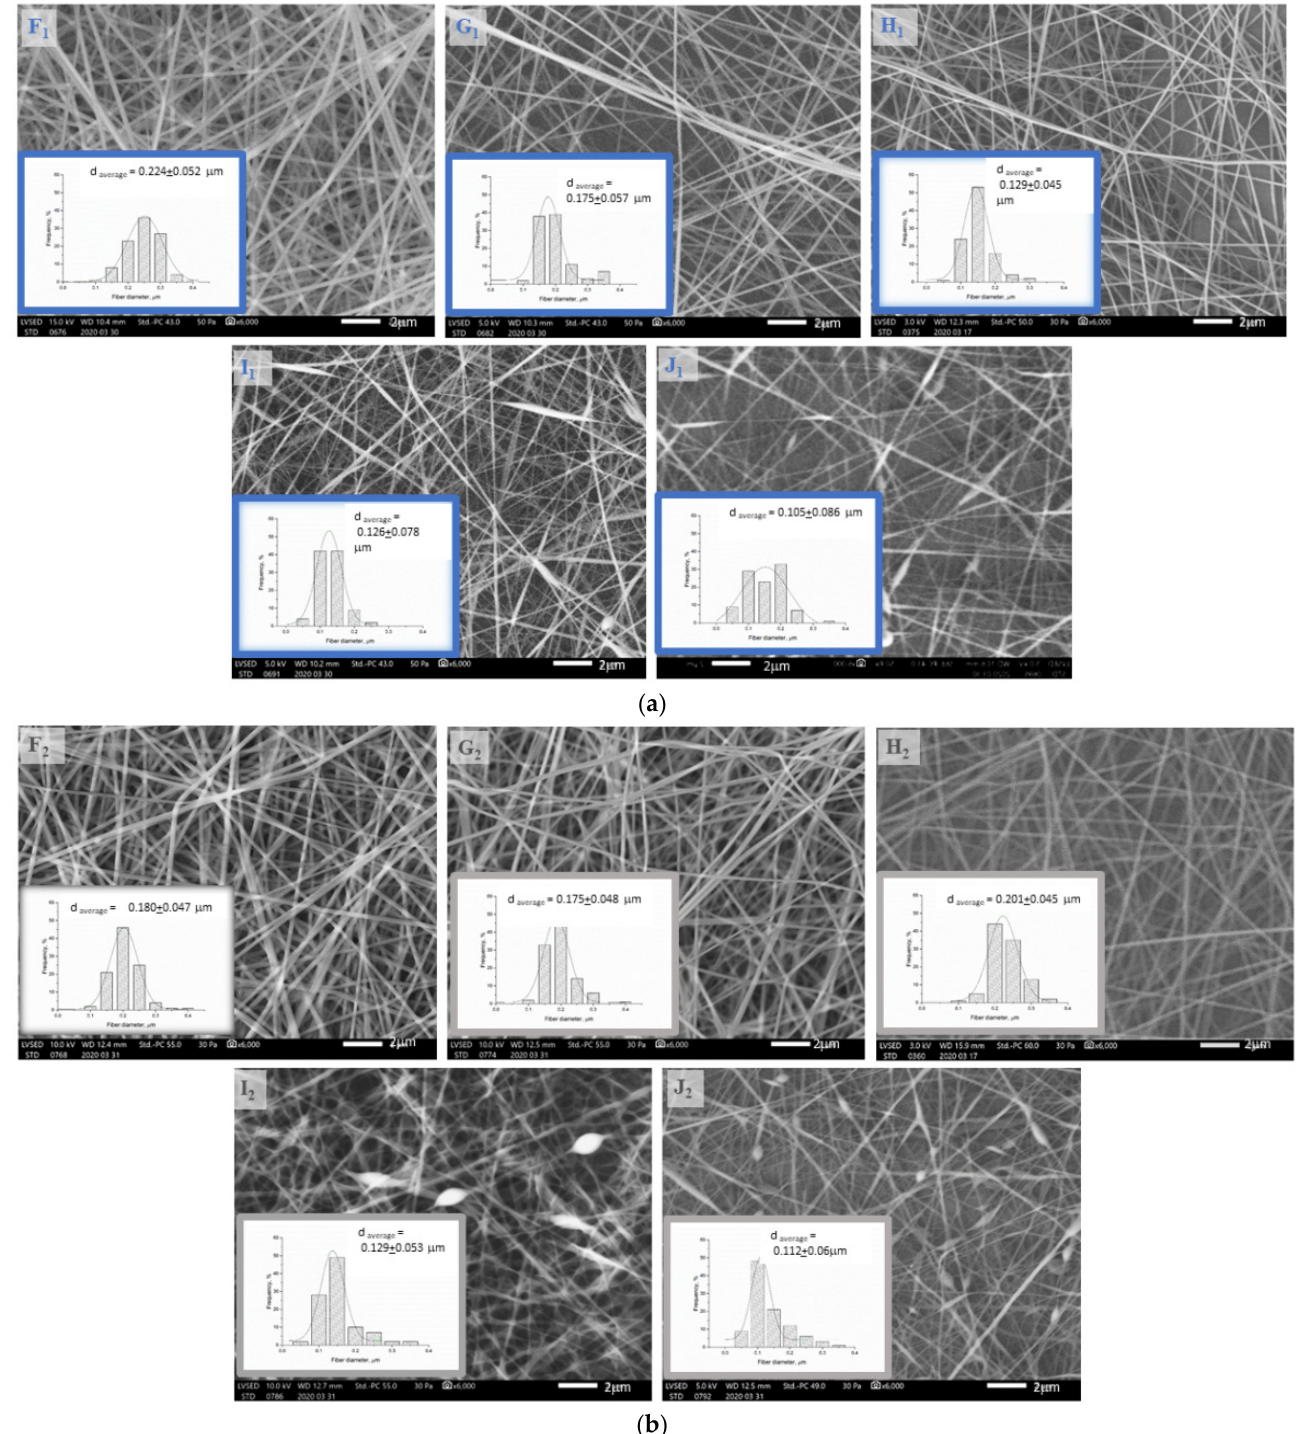
Figure 3. ( a ) The scanning electron microscopy images and distribution curves of native (F 1 , G 1 , H 1 , I 1 , J 1 ) fiber samples taken at 6000× resolution. ( b ). The scanning electron microscopy images and distribution curves of heat-treated (F 2 , G 2 , H 2 , I 2 , J 2 ) fiber samples taken at 6000× resolution .